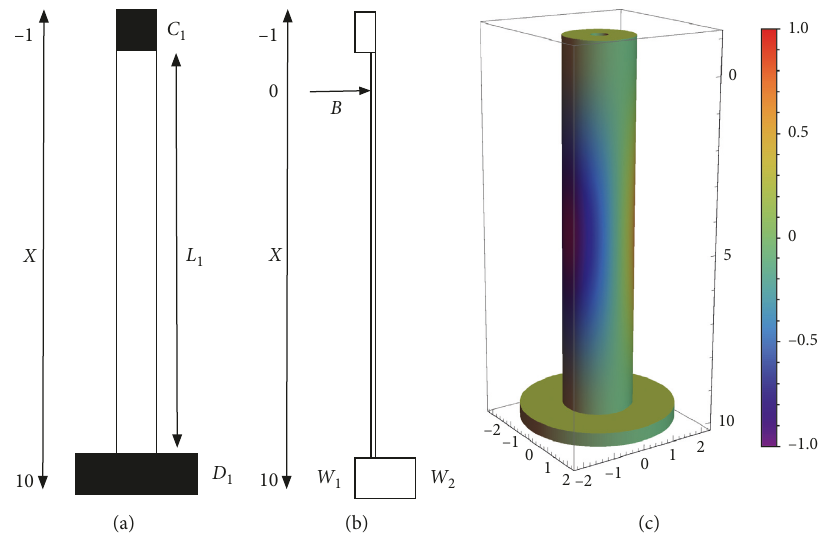
Figure 2: Tower configuration: Computational domain; B indicates the location of the assumed manufacturing imperfections at x � 0. (a) Shell-solid model; diameter of the base is random. (b) Computational domain. (c) Lowest mode; normalized transverse detection w ; rainbow colour